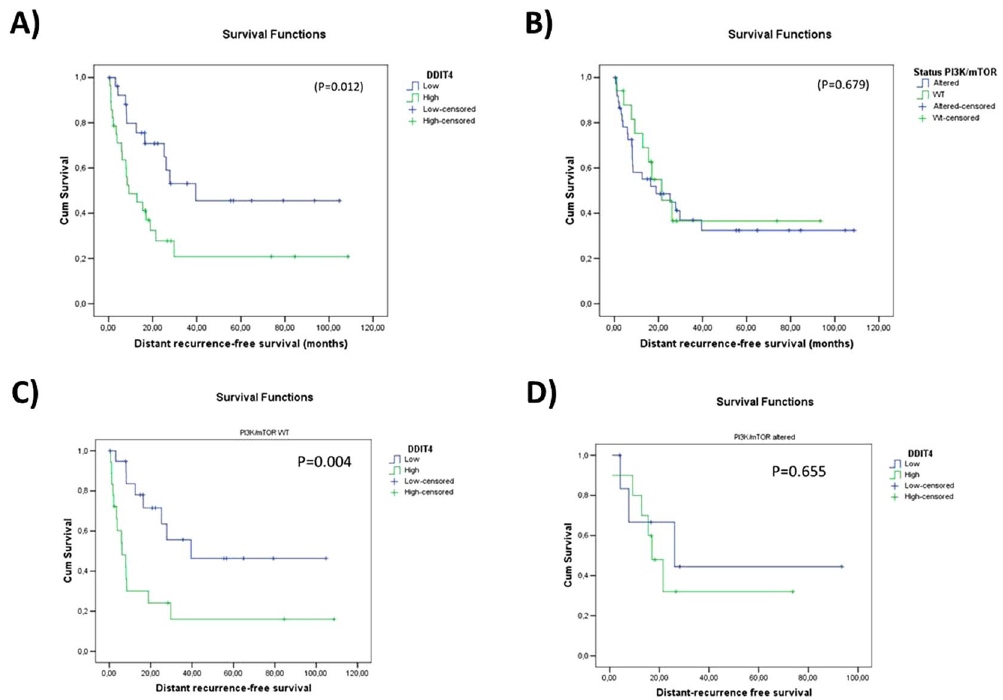
Figure 8. Evaluation of DDIT4 expression and PI3K/mTOR pathway alterations in TNBC. Kaplan-Meier plots for DRFS in a cohort of 58 TNBC patients. ( A ) Patients with a high expression of DDIT4 had a worse outcome (P = 0.012). ( B ) PI3K/mTOR pathway alterations had no influence in the outcome (P = 0.679). When the cohort was split according to the PI3K/mTOR pathway status, differences in survival was observed in patients with unaltered PI3K/mTOR pathway ( C ), in patients with altered PI3K/mTOR pathway was not observed differences ( D